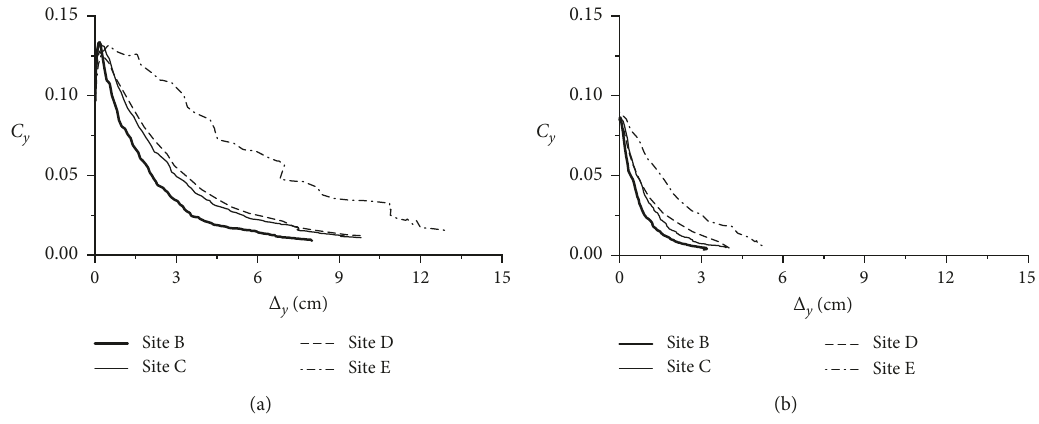
Figure 5: Effects of the soil site on YPS considering two ductility factors: (a) μ � 2; (b) μ � 5.